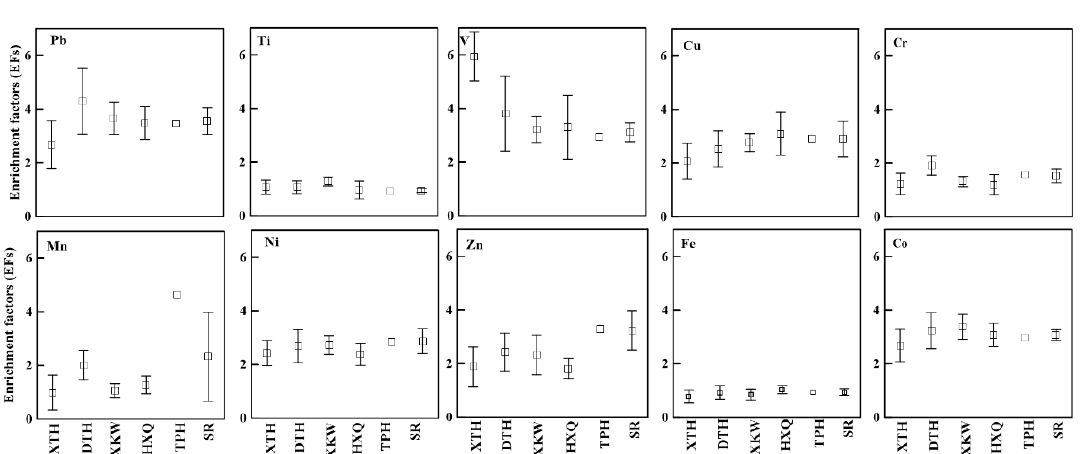
Table 2. Concentration and accumulation of heavy metals in aquatic plants in Taihu Lake.